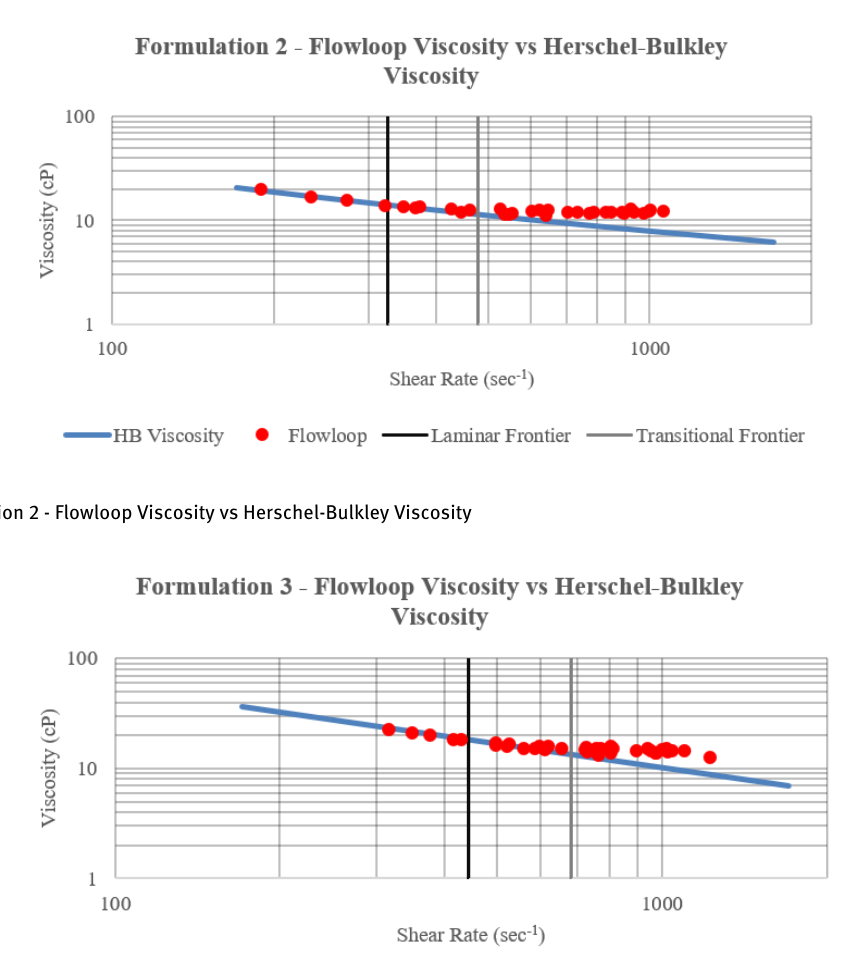
Figure 11: Formulation 1 - Flowloop Viscosity vs Herschel-Bulkley Viscosity